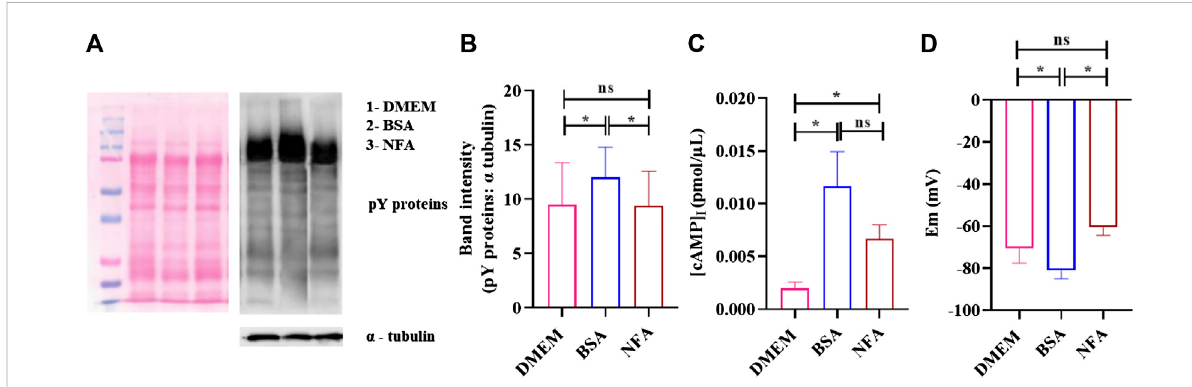
FIGURE 5 NFA at chemotactic concentrations does not induce capacitation. Protein tyrosine phosphorylation, [cAMP] I , and membrane potential was determined insperm incubated inDMEM, 2.5%BSA, or0.01 MNFA for2.5 h. Proteintyrosine phosphorylation wasdetectedbyWesternblotanalysis usingmouseanti-phosphotyrosineandHRP-conjugatedgoatanti-mouseasprimaryandsecondaryantibodies,respectively.Arepresentativeimage of the Western blot for pY proteins (right) and its corresponding ponceau-stained blot (left) are shown (A) . The band intensities of tyrosine- phosphorylatedproteinsnormalizedtothatoftheloadingcontrol, α -tubulin,areshown (B). [cAMP] I wasassessedbycompetitiveELISA.Absorbance wasmeasuredat480 nm.The fi gure shows agraph of[cAMP] I levels underdifferentconditions (C) .Thesperm membranepotential wasdetermined using DiSC3-based fl uorimetric assays. Represented are absolute Em (mV) values of the sperm membrane after treatment (D) . Values represent the mean ± SD of three independent experiments. (*p < 0.05; **p <